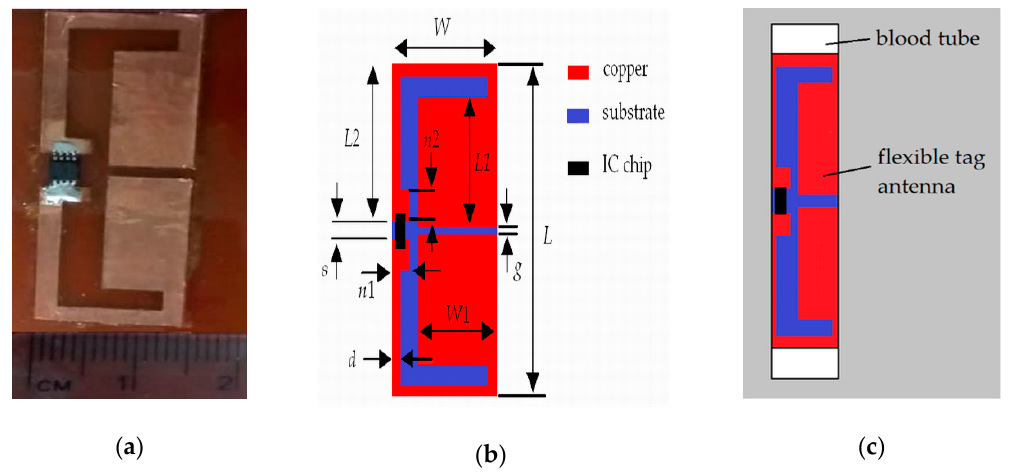
Figure 2. Proposed flexible ultra-high frequency (UHF) radio frequency identification (RFID) tag antenna. ( a ) Photograph of the tag antenna attached to a flat surface (FR4 substrate). ( b ) Structure and dimensions. ( c ) Flexible tag antenna attached to a blood tube.